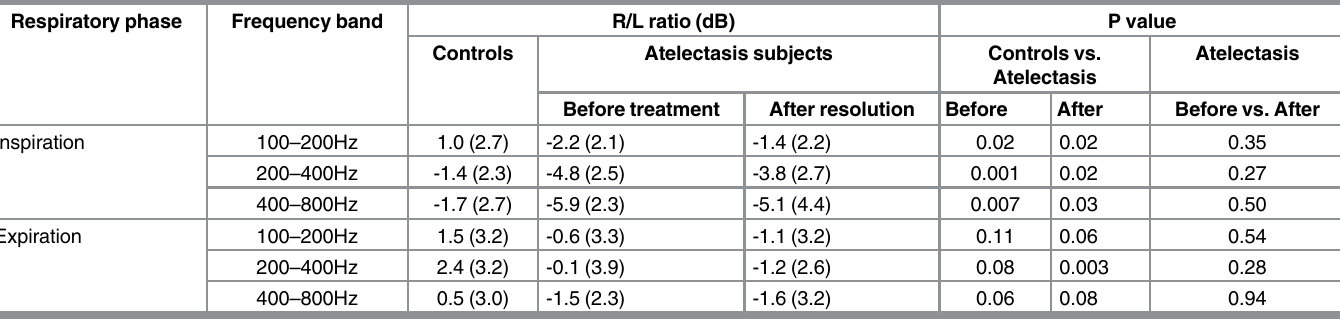
Table 3. Comparison of right-to-left ratios (R/L ratios) of breath sound sound pressure between controls and atelectatic